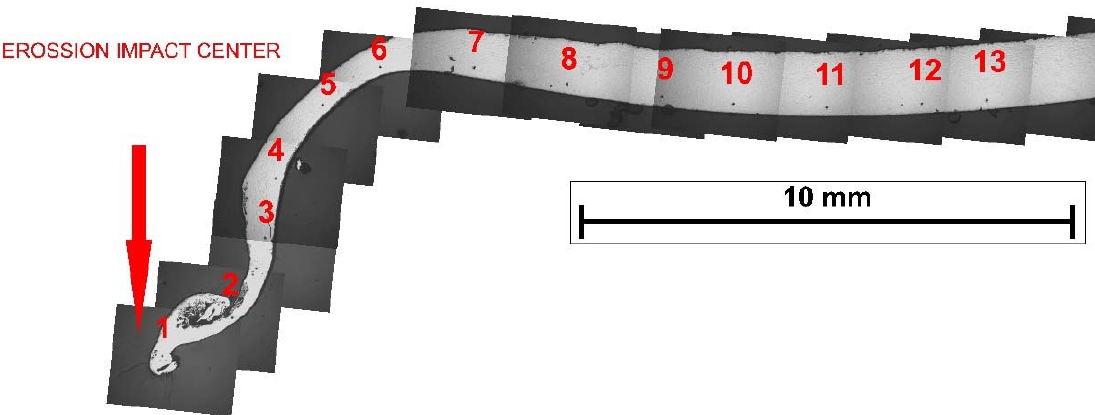
Figure 3. The DC05 sample after the 30 s erosion test subjected to hardness measurements: ( 1 – 13 ) Measuring points.